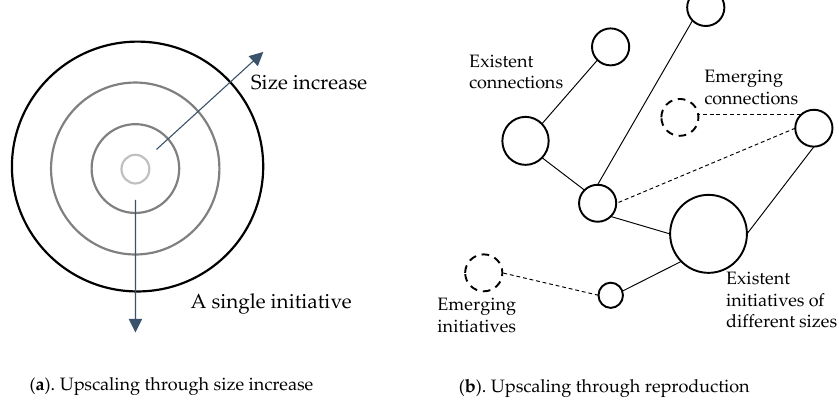
Figure 2. Two forms of scalability.